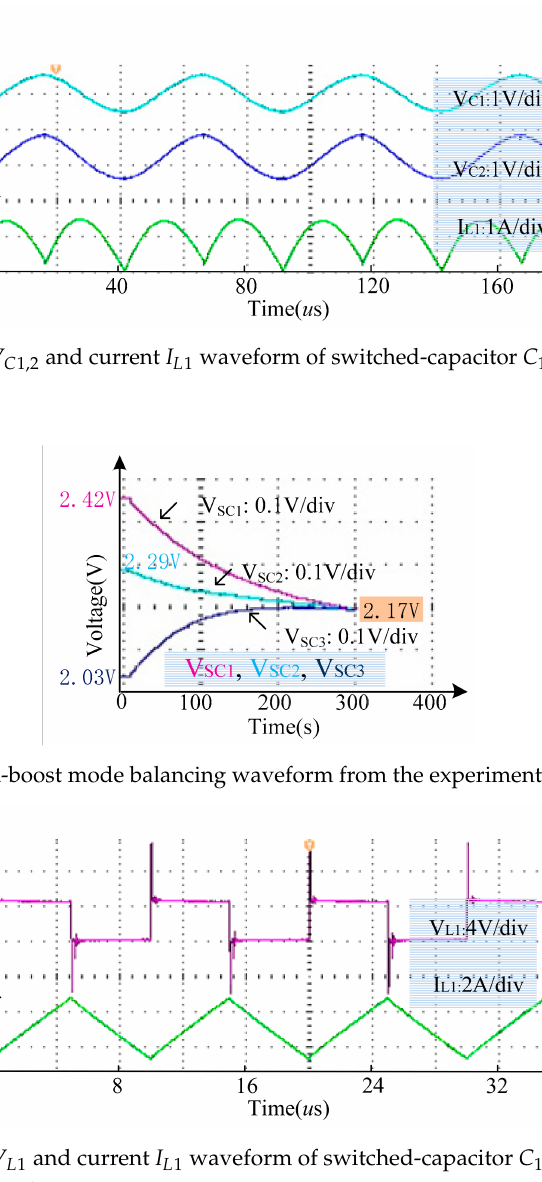
Figure 14. The voltage V L 1 and current I L 1 waveform of switched-capacitor C 1 during the balancing progress of buck-boost